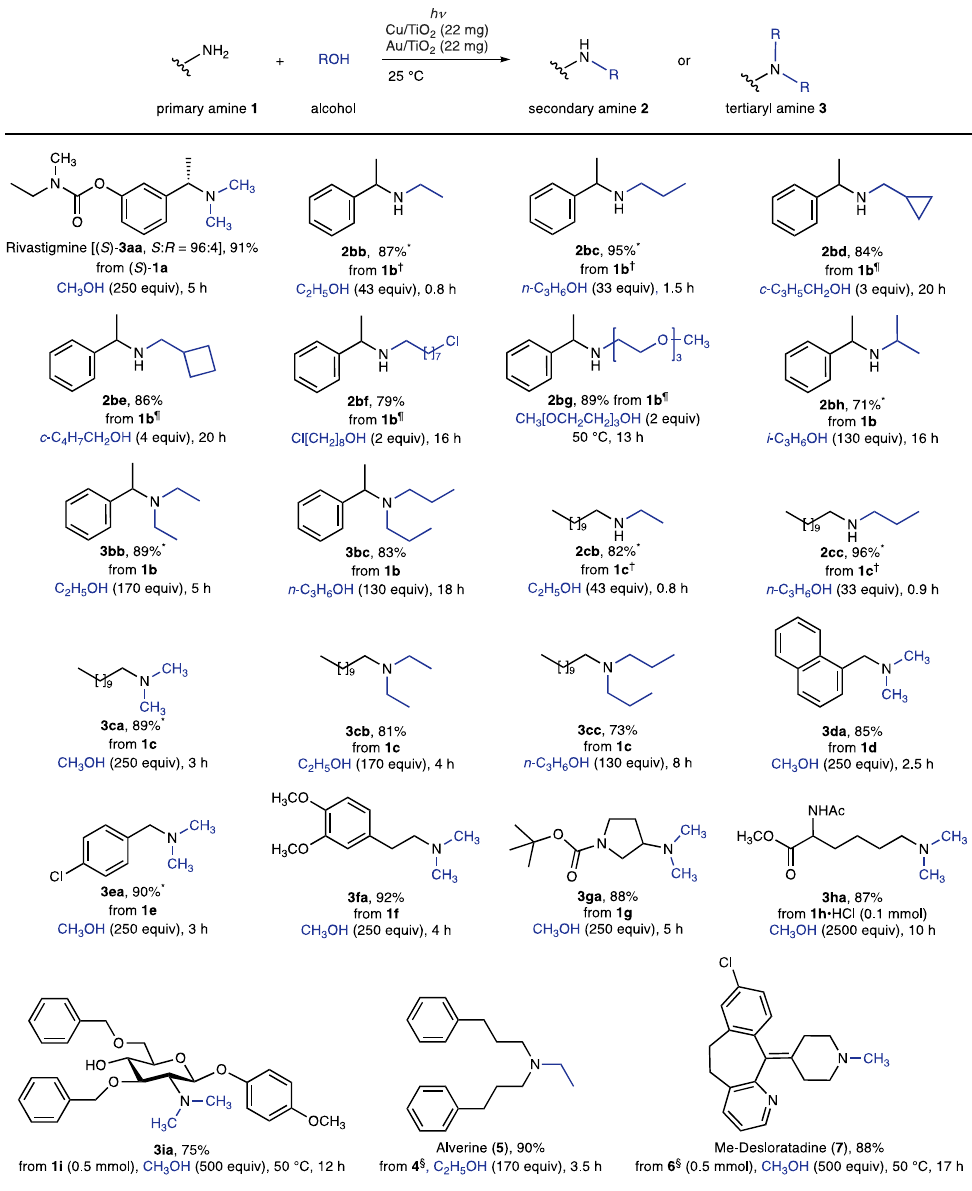
Figure 3. Substrate scope in synergistic Cu–Au photocatalysis. Conditions are analogous to Fig. 2, entry 13. Isolated yields are reported. * Isolated yield of HCl salt. † Conditions: 1 (0.2 mmol), hexane (10 mL). ¶ Solvent = CPME (10 mL). § 4 = bis(3-phenylpropyl)amine; 6 =